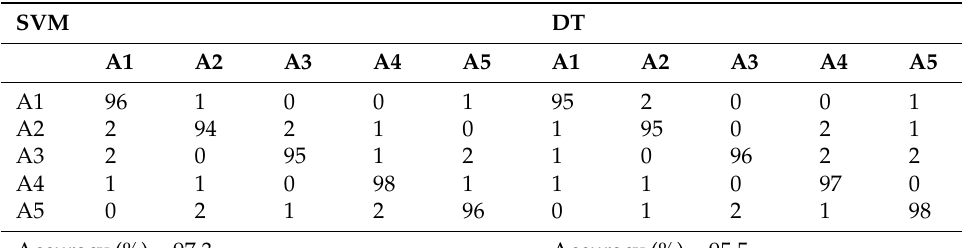
Table 7. Classification of A1–A5 signal events.